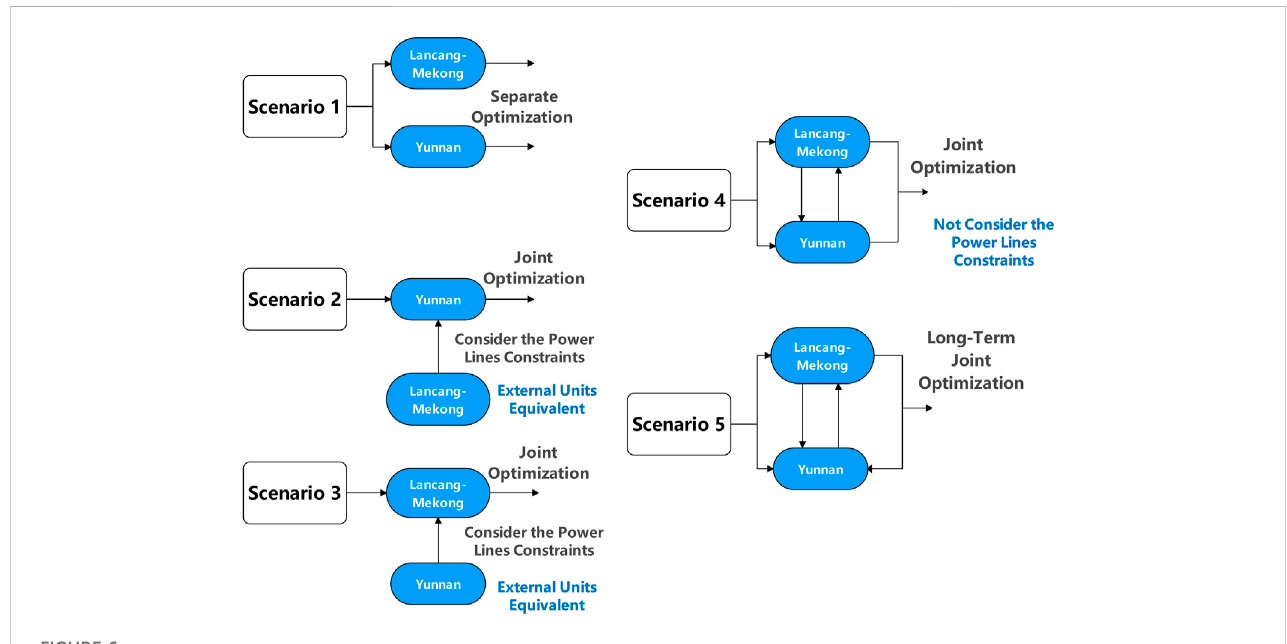
FIGURE 6 Boundary conditions under different